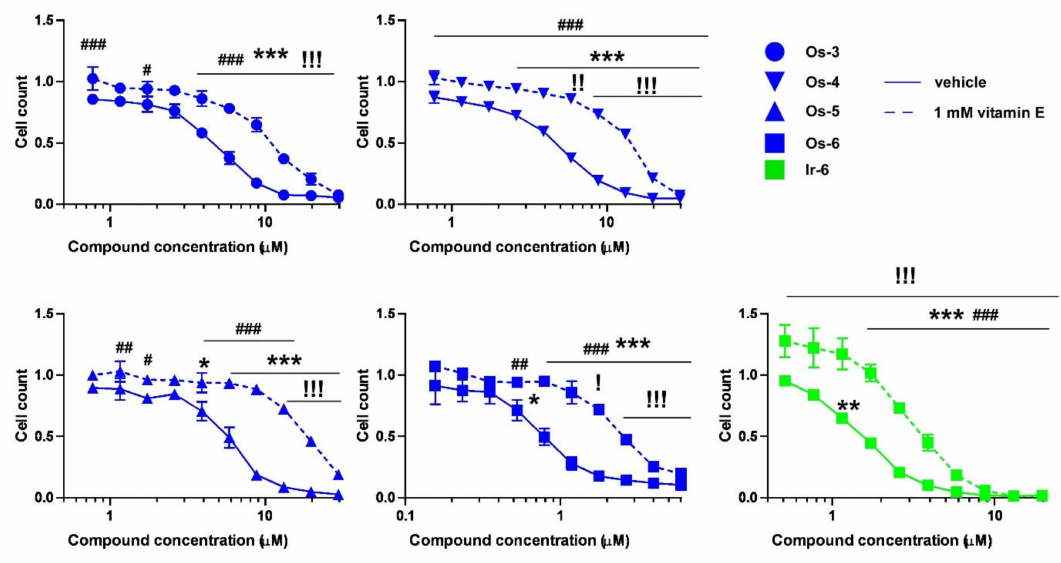
Figure 10. Assessment of selected Os(II) and Ir(III) complexes ( Os-3-Os-6 , Ir-6 ) for cytostatic activity. Here, 1.5 × 10 3 A2780 cells were plated onto 96-well plates. Cells were treated with the compounds in the concentrations indicated for 48 h for an SRB assay with or without 1 mM vitamin E. Data are represented as average ± SD, from three biological replicates; individual assays were performed in duplicate. Values were normalized for vehicle-treated cells. Absorbance for vehicle-treated cells is equal to 1. Normality was assessed using the d’Agostino and Pearson test. Os-3, Os-4, Os-6, Ir-6 data had normal distribution, while in Os-5 , normality was achieved using the Box-Cox normalization method. Statistical difference was assessed using a two-way ANOVA test; all measurement points were compared with each other. *, ** and *** indicate statistically significant differences between vehicle-treated (control) cells and those treated with a compound but not with vitamin E, at p < 0.05 and p < 0.001, respectively. #, ##, and ### indicate statistically significant differences between vehicle- treated (no Vitamin E) and the cells treated with a Vitamin E at p < 0.05, p < 0.01 and p < 0.001, respectively. !, !!, and !!! indicate statistically significant differences between vitamin E and vehicle- treated cells (control) and the cells treated with vitamin E and a compound at p < 0.05, p < 0.01 and p < 0.001,